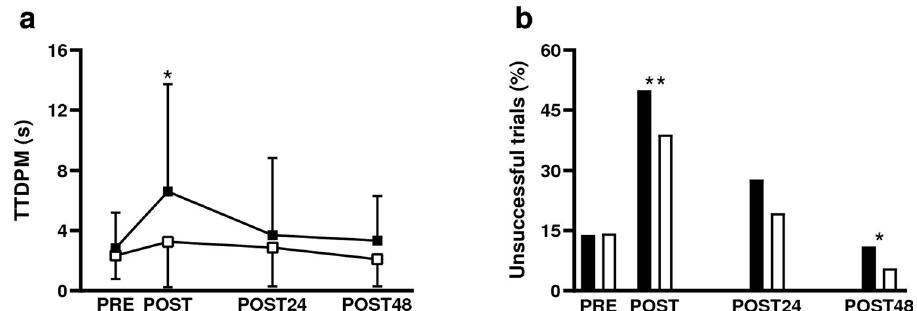
Figure 3. Effects of the eccentric exercise on knee movement sense. ( a ) TTDPM best trial values and ( b ) percentages of unsuccessful trials during TTDPM tasks before (PRE), immediately after (POST), and 24 (POST24) and 48 (POST48) hours after the eccentric exercise. * and ** Significantly different from PRE values at p < 0.05 and p < 0.01, respectively. TTDPM FLEX Threshold To Detect Passive Movement into flexion at 30° of knee flexion, TTDPM